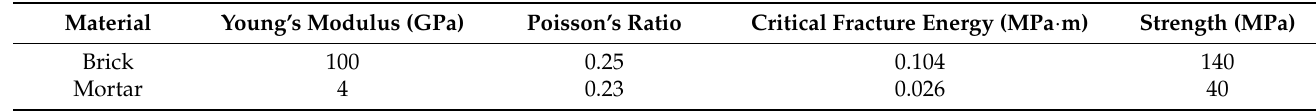
Table 1. Mechanical properties of nacre in finite element model [27,28].